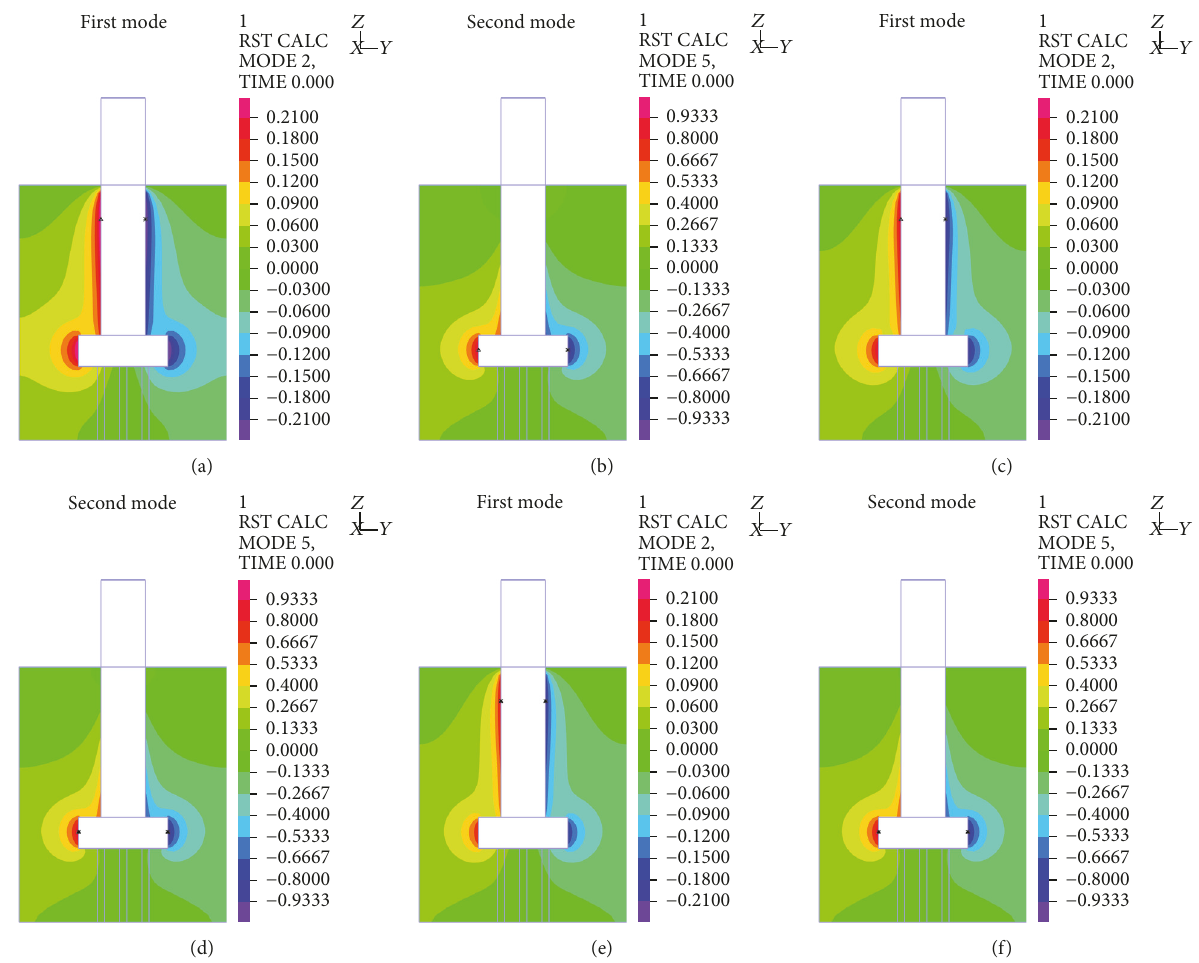
Figure 22: Nondimensional modal hydrodynamic pressures on the pier specimen in the first two modes along 𝑦 -axis, with a water level, 𝐻 w , of 1.8 m, along 𝑦 = 0 m cutting plane, corresponding to a tip mass of (a) and (b) 12.1kg; (c) and (d) 23.4 kg; (e) and (f) 31.7